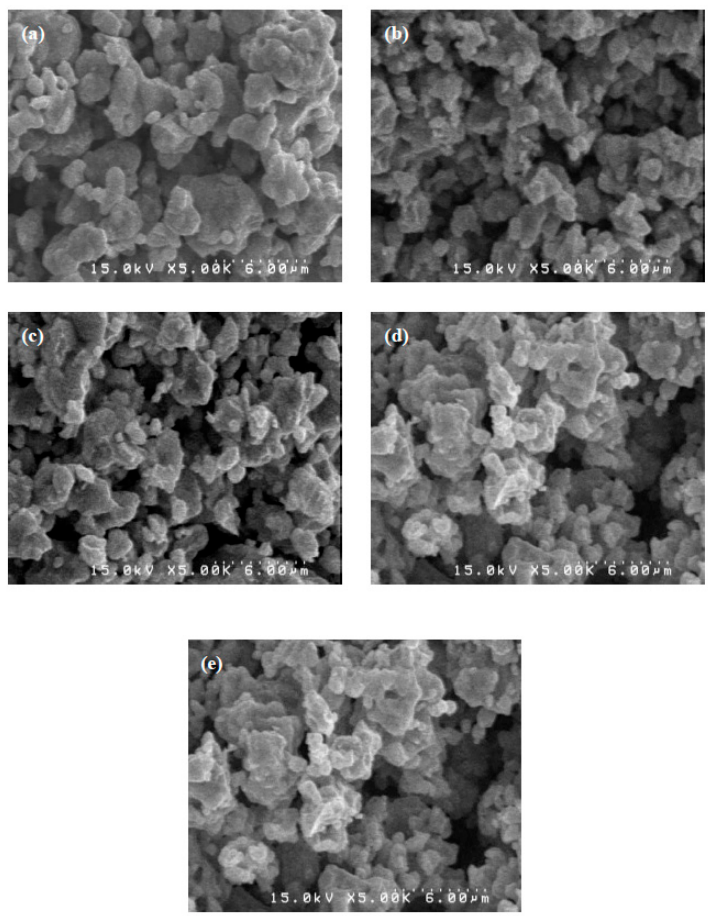
Figure 2. The SEM micrograph of YInGe 2 O 7 doped with ( a ) 1; ( b ) 3; ( c ) 5; ( d ) 10; and ( e ) 20 mol % Sm 3+ ions powders calcined at 1300 °C for 10 h in air.